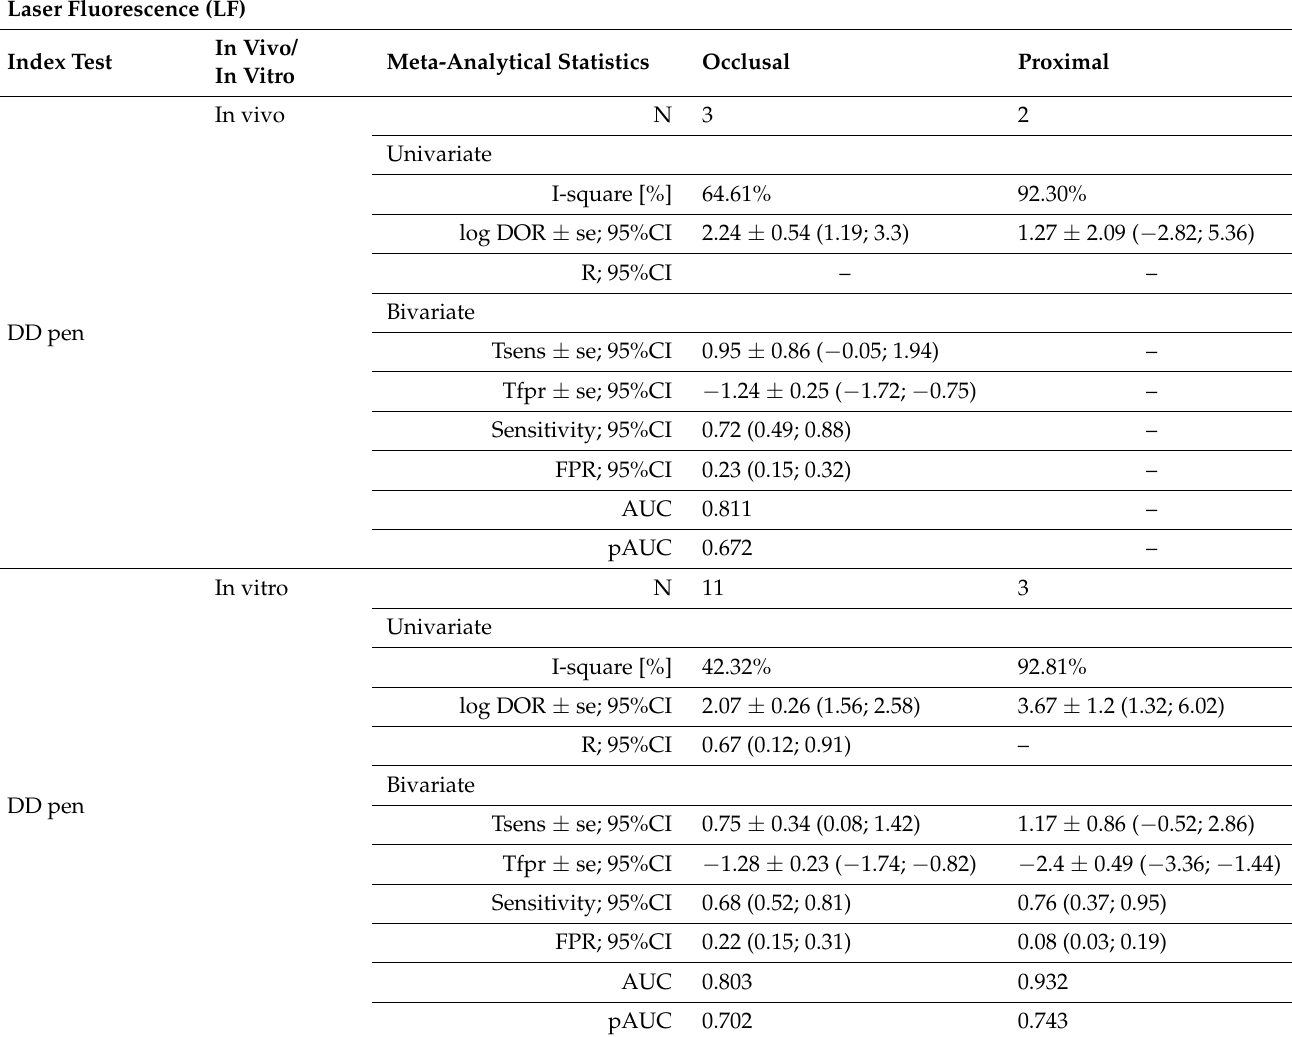
Table 3. Meta-analytical results for the DD pen test. The sub-group of 11 studies reporting occlusal in vitro results, with I-squared = 42.32%, underwent comprehensive meta-analysis (including